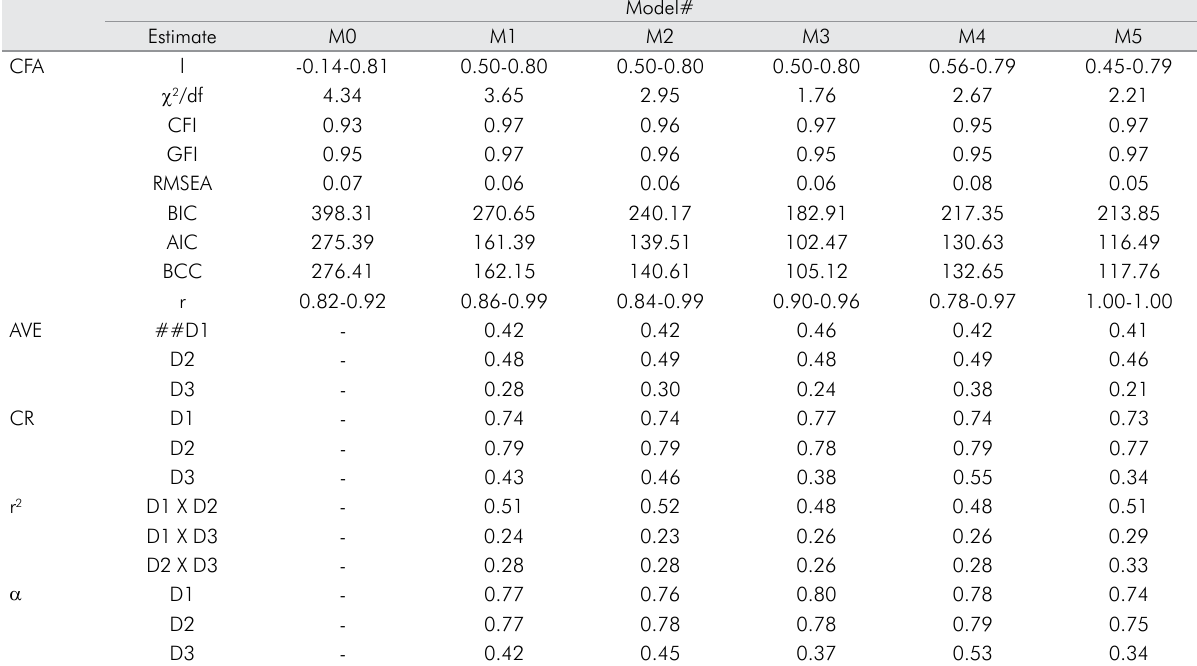
Table 2. Goodness of fit indices of the confirmatory factor analysis (CFA), convergent validity (AVE), composite reliability (CR) of the models fitted to different samples/models (M0-M5), Pearson correlation between factors (r), squared correlations (r 2 ), and internal consistency ( α ) for the Geriatric/General Oral Health Assessment Index (GOHAI). Araraquara - SP / Brazil, 2011.